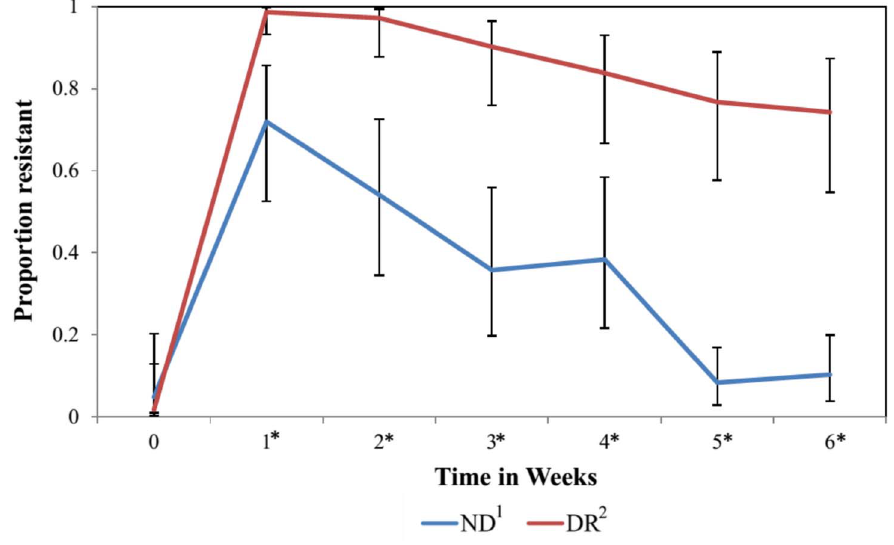
Fig. 5. Proportion of E. coli resistant to 3 or more antimicrobial drugs by milk feeding treatment overtime in weeks. Error bars represent 95% confidence interval of the least square mean. 1. Calves fed raw milk without the addition of sub-MICs of antimicrobial drugs. 2. Calves fed raw milk with the addition of sub- MICs of ceftiofur, penicillin, ampicillin, and oxytetracycline from birth to 6 weeks of age. *Sampling weeks where the the proportion of resistant isolates resistance to 3 or more antimicrobial drugs was significantly different between NR and